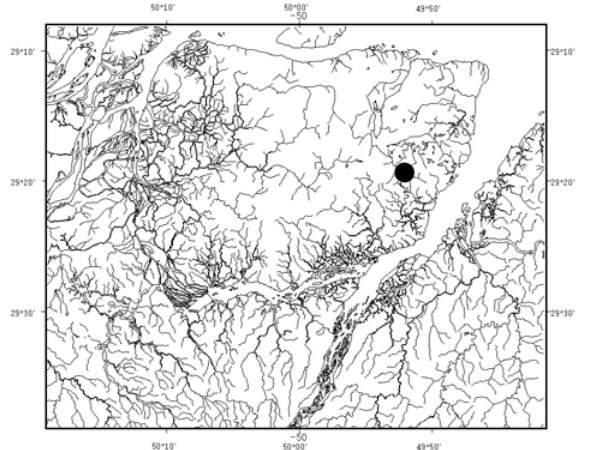
Fig. 3 . Map of part of northern Brazil showing the type local- ity of Synbranchus lampreia . Brazil, Pará, ilha de Marajó, rio Goiapi, tributary of rio Arari, Cachoeira do Arari, approx. 0°58’S 48°57’W.